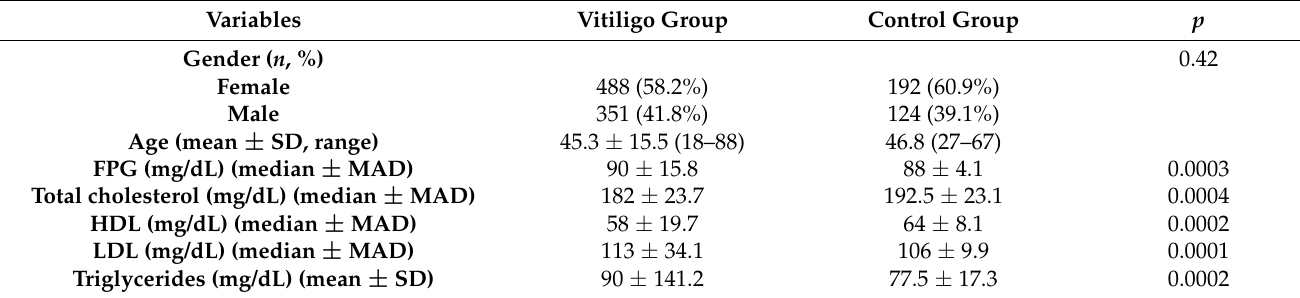
Table 1. Demographic features and serum metabolic parameters of the study and control group patients. Variables Vitiligo Group Control